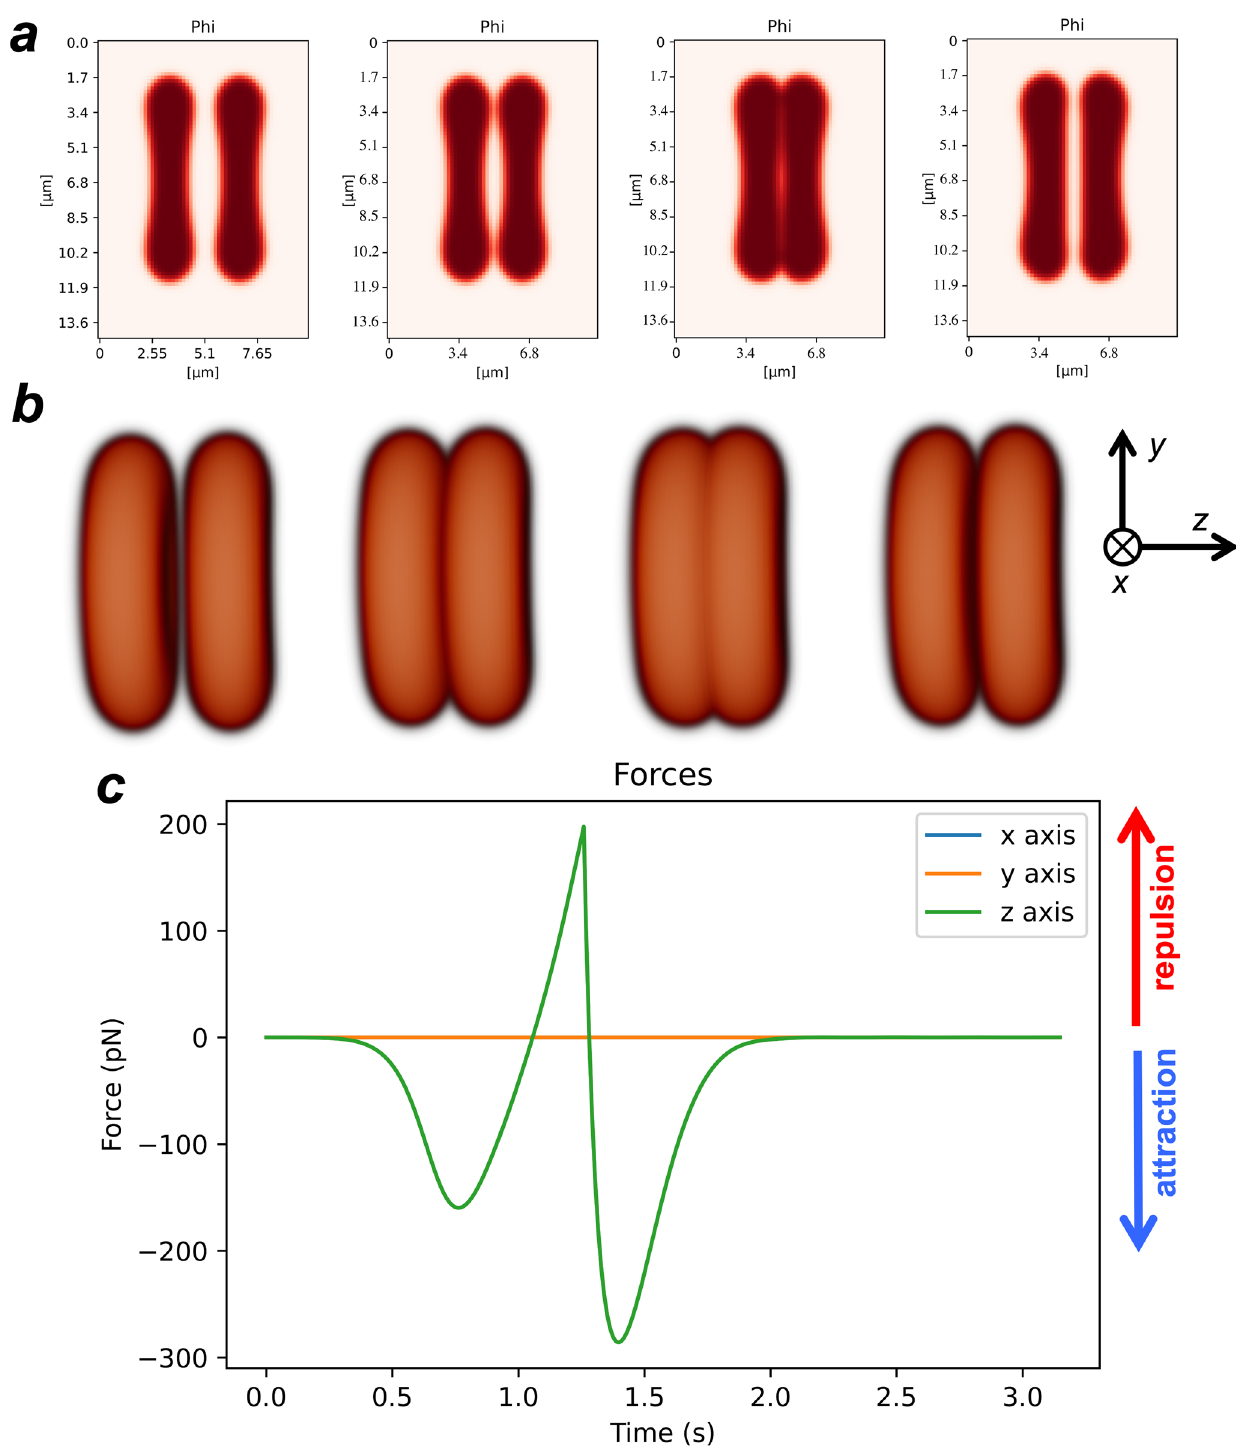
Fig. 4 Simulation time-lapse of two aligned erythrocytes being pushed against each other and then pulled apart. a Mid-slice pro fi le, and b the corresponding 3D representation. The images correspond to the times t = 0, 0.62, 1.25, 1.88 s. c Total force applied on the right erythrocyte by the left erythrocyte as a function of